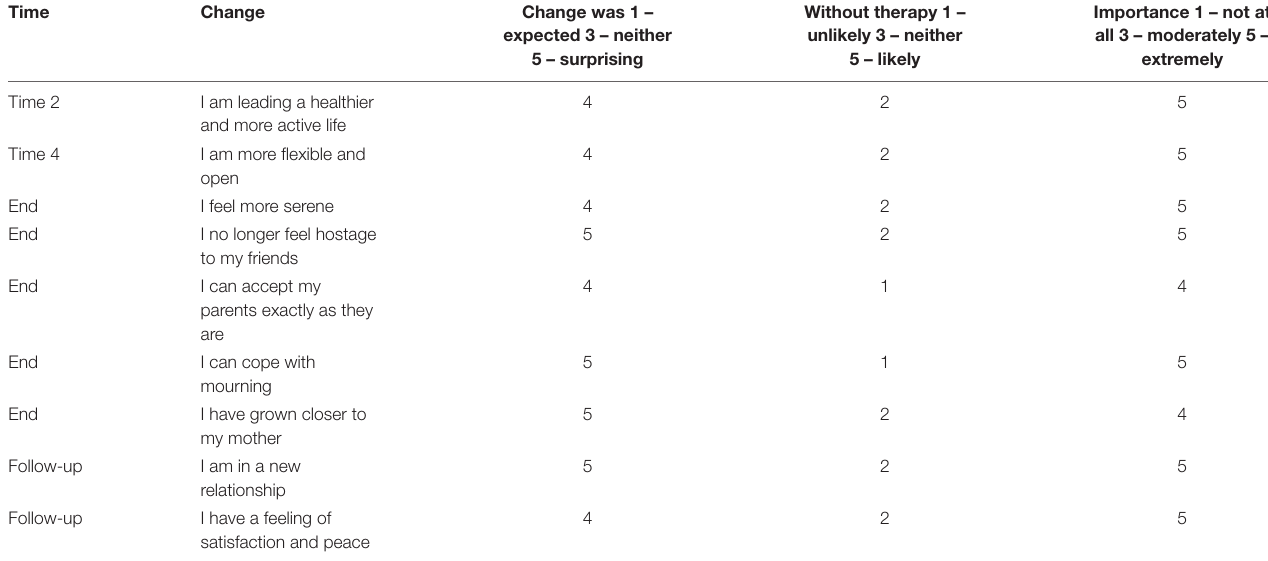
TABLE 4 | Most important changes stated in John’s